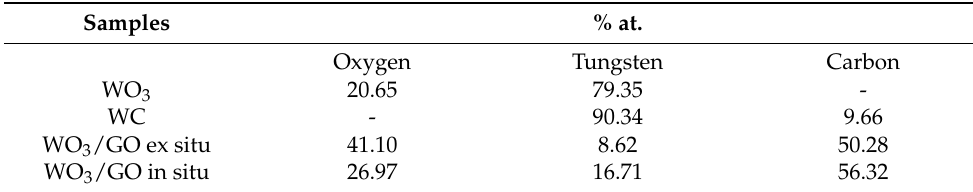
Table 1. Elemental composition of WO 3 , WC and WO 3 /GO in ex situ synthesis and in WO 3 /GO in situ synthesis.